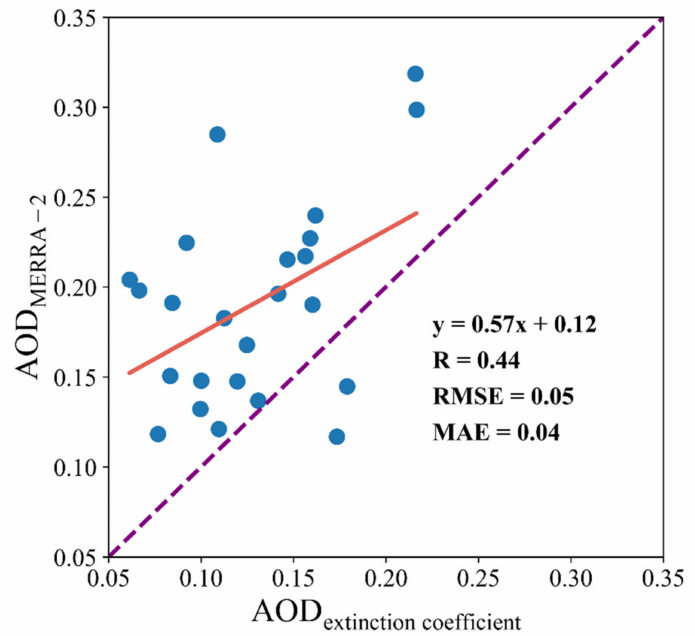
Figure 11. Scatter plot of MERRA-2 and the observations of AOD at 550 and 532 nm, respectively, during the voyage from 8 June to 2 July 2019. The purplish dotted line represents the 1:1 line. The red line represents the fitting curve. The correlations coefficient (R), the root mean square error (RMSE), and the mean absolute error (MAE) are indicated in the